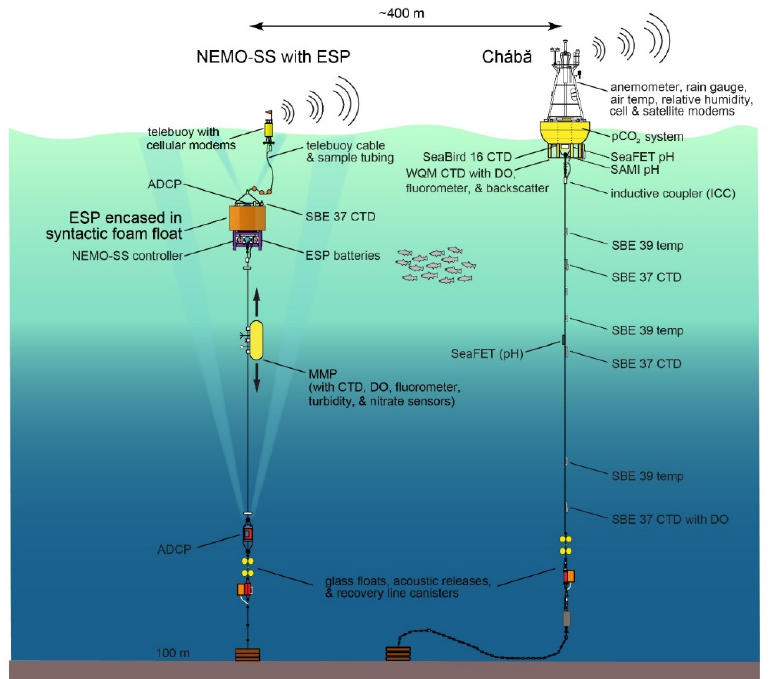
Figure 2. Schematic of the Northwest Enhanced Moored Observatory (NEMO) showing the NEMO subsurface mooring (NEMO-SS) with the Environmental Sample Processor (ESP) integrated at ~18 m depth and nearby Cháb ă mooring. Depth of individual system components not to scale.